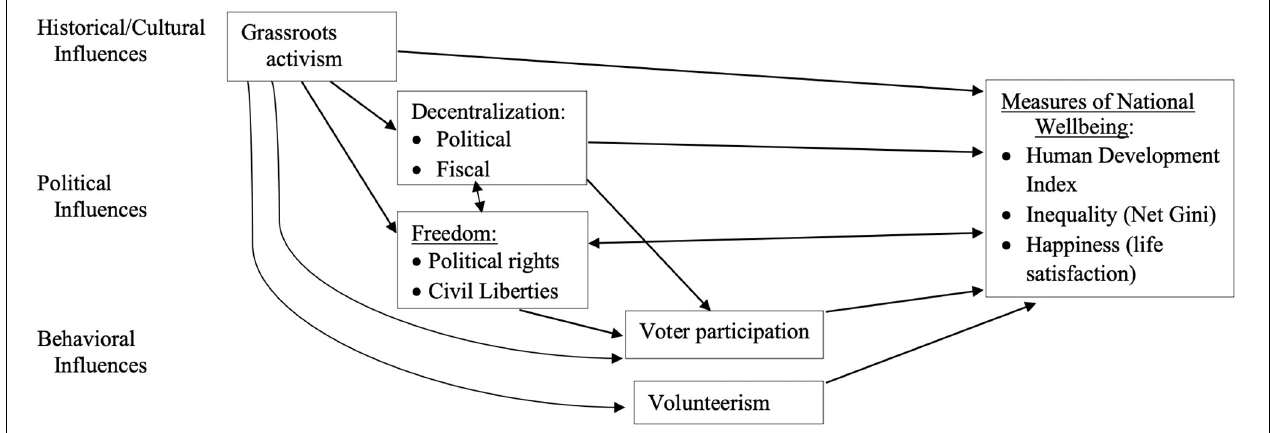
FIGURE 1 | Hypothesized Political, Social Justice, and Citizenship Predictors and Measures of National Well-being.